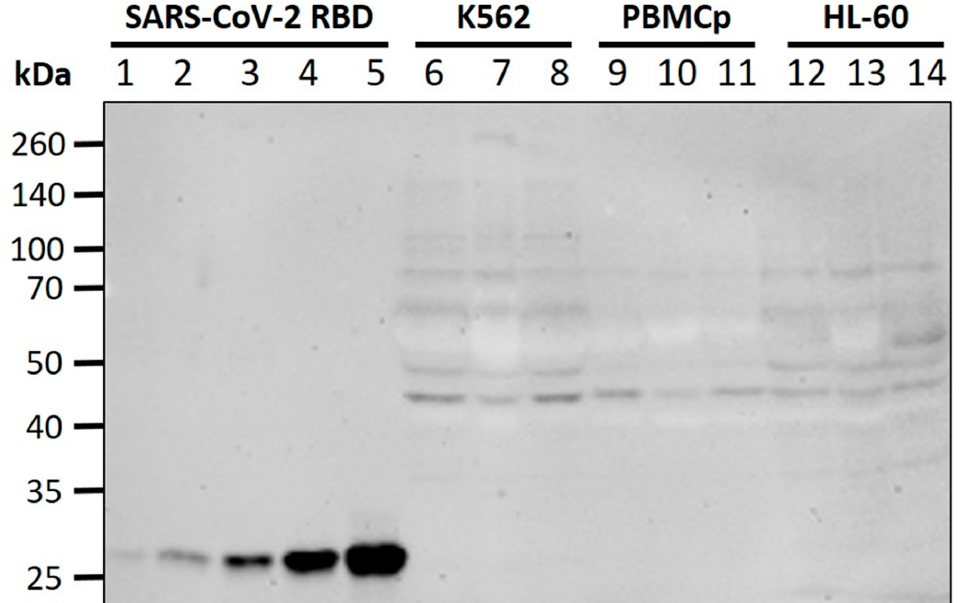
Figure 3. Western blot for S-protein expression. Lanes 1–5: recombinant SARS-CoV-2 S-protein RBD (0.25 pmol, 0.5 pmol, 1 pmol, 2 pmol, 4 pmol); Lanes 6–8: K562 lysates (control, 12 h, 3 h); Lanes 9–11: PBMCp lysates (control, 24 h, 3 h); Lanes 12–14: HL-60 lysates (control, 12 h, 3 h). No difference